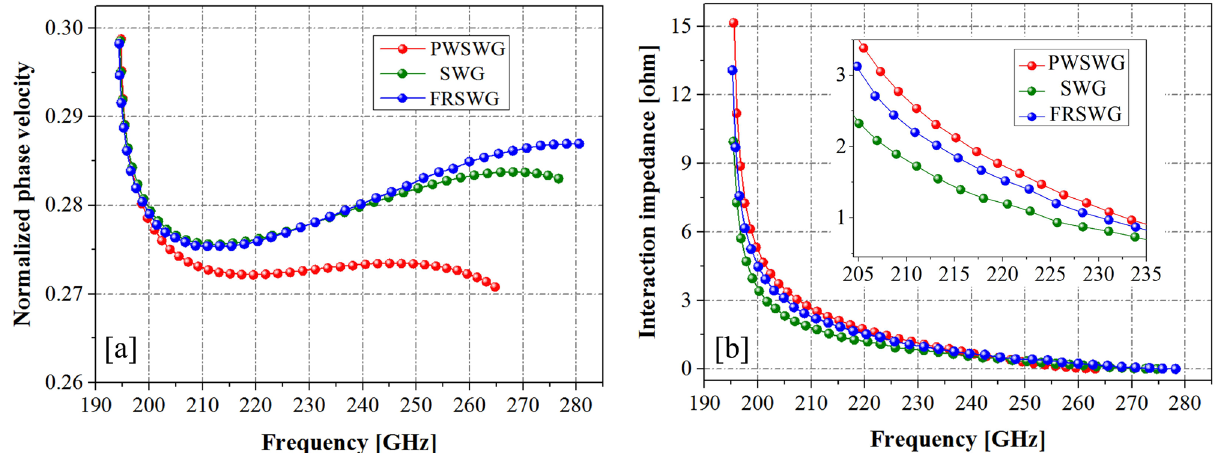
Figure 6. Comparisons of slow wave characteristics between the PWSWG SWS, the SWG SWS and the FRSWG SWS.